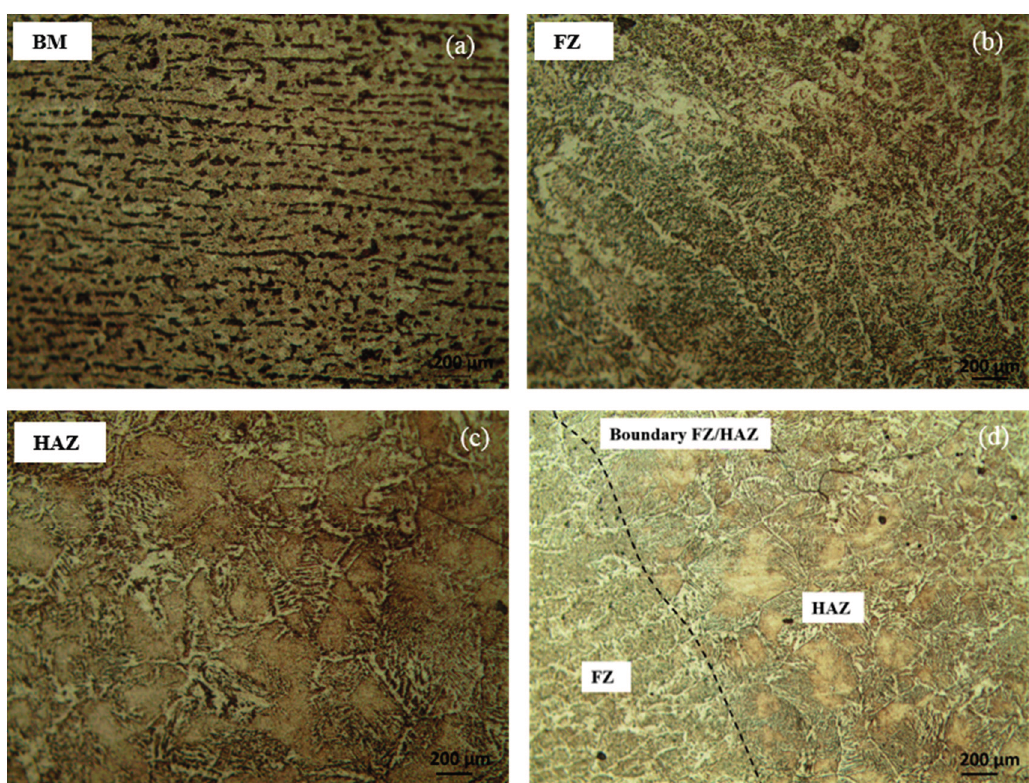
Figure 18. Microstructures ( a ) BM (base metal); ( b ) FZ (fusion zone); ( c) HAZ (heat affected zone); and ( d ) boundary differentiating HAZ and